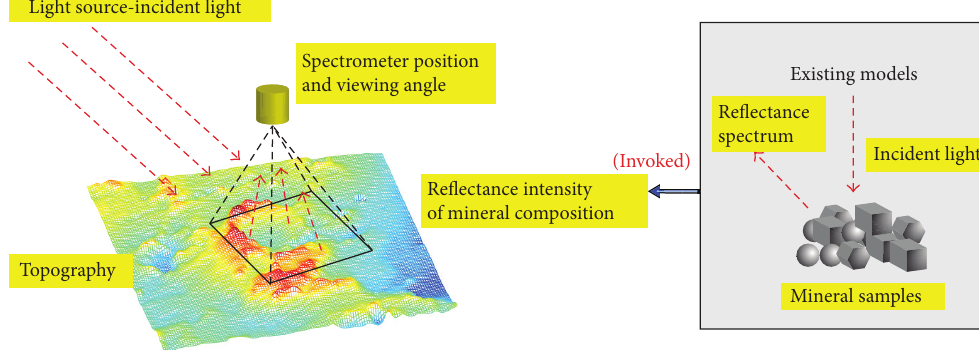
Figure 1: The schematic view of our method.